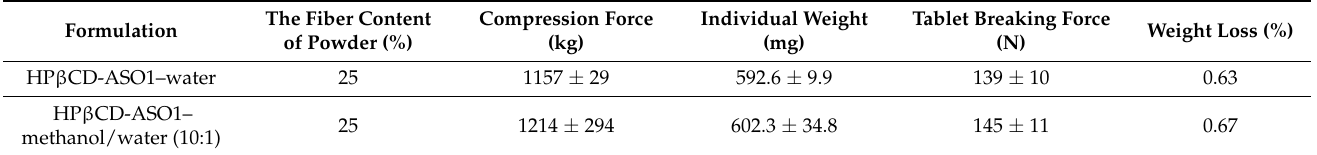
Table 5. Properties of ASO1-containing tablets calculated as an average of 10